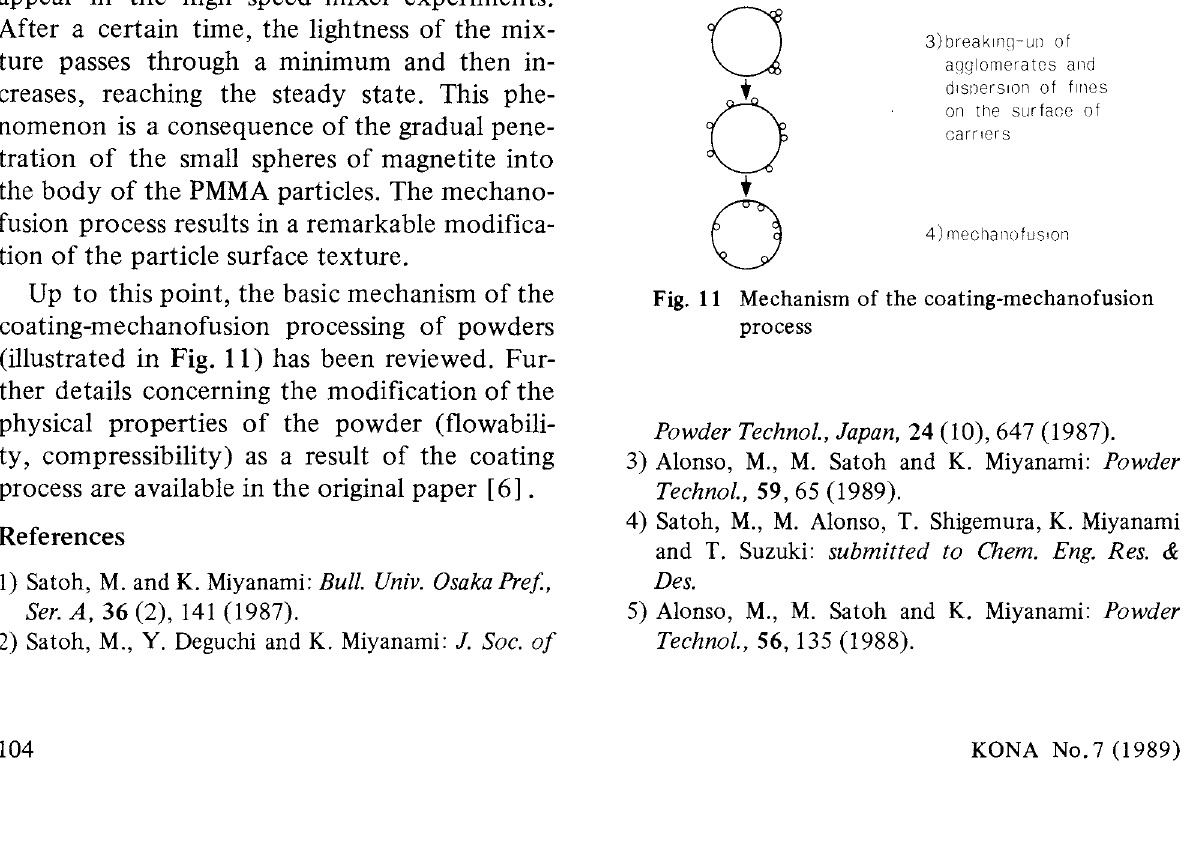
Fig. 10 Temporal variation of the color of the mixture (HSSM: high speed stirred mixer; AMS: Angmill mechanofusion system)